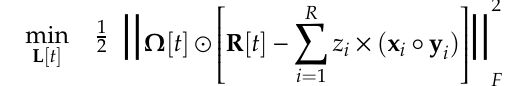
Algorithm 1 OLCP-InSAR for tensor model